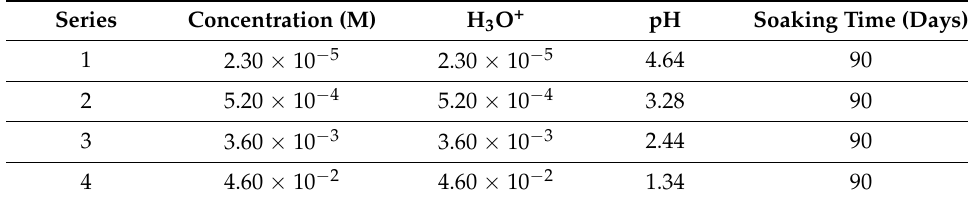
Table 1. Acidic submersion of